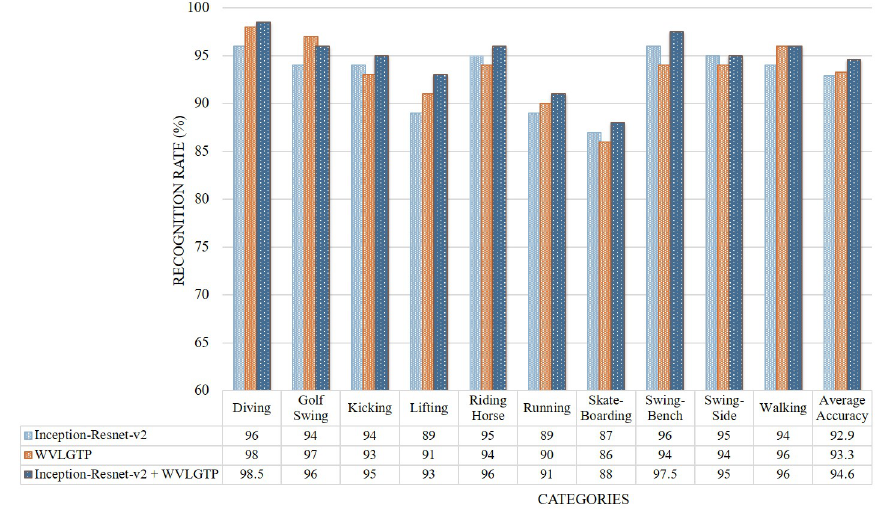
Figure 10. Accuracy comparison of each class by Inception-Resnet-v2, WVLGTP, and Inception-Resnet-v2 plus WVLGTP on the UCF sports action dataset.